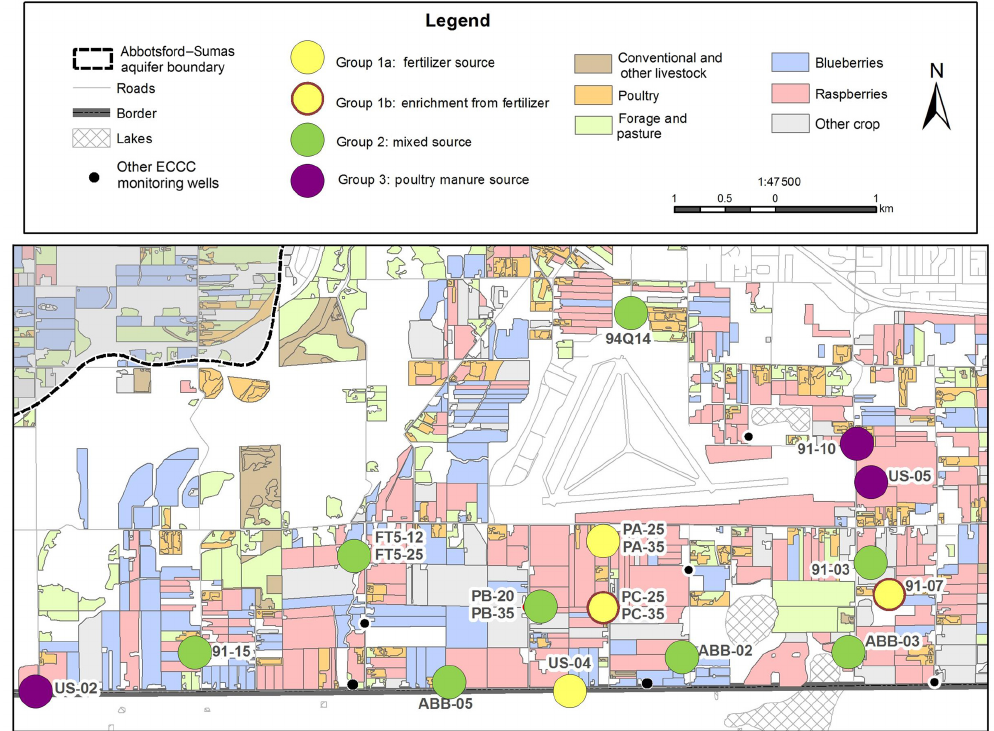
Figure 4. Spatial distribution of δ 15 N source groupings, along with agricultural land